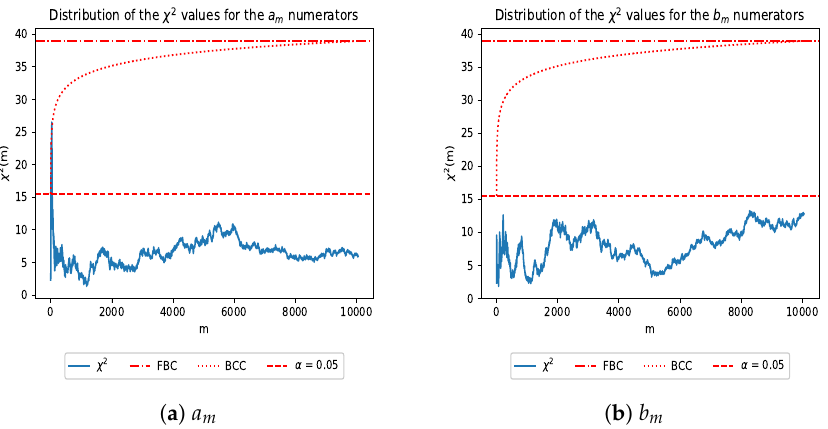
Figure 3. χ 2 distribution for the a m and b m numerators. Legend Guide: FBC-Final Bonferroni Correction, BCC-Bonferroni Correction